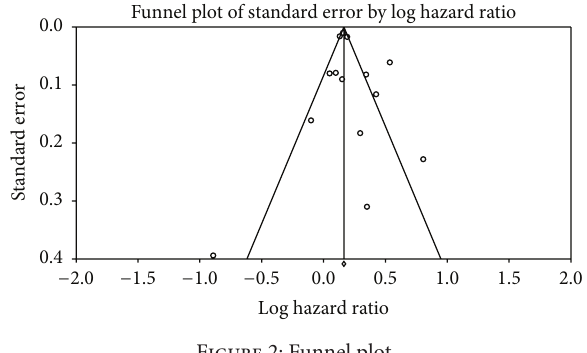
Figure 2: Funnel